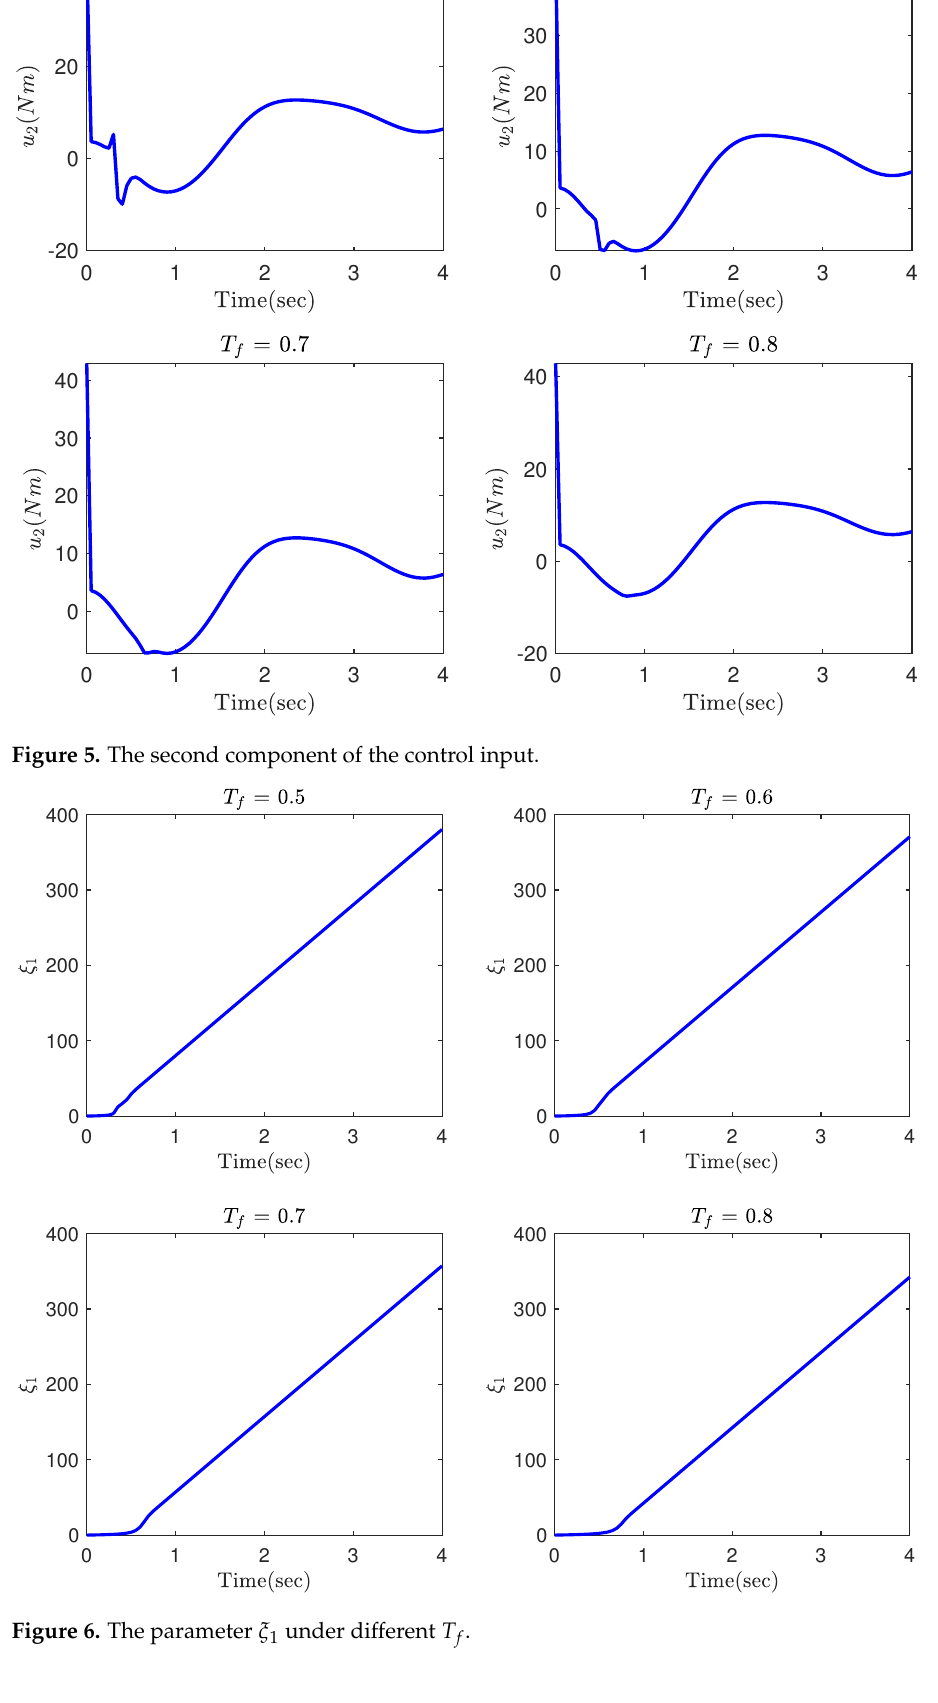
Figure 6. The parameter ξ 1 under different T f